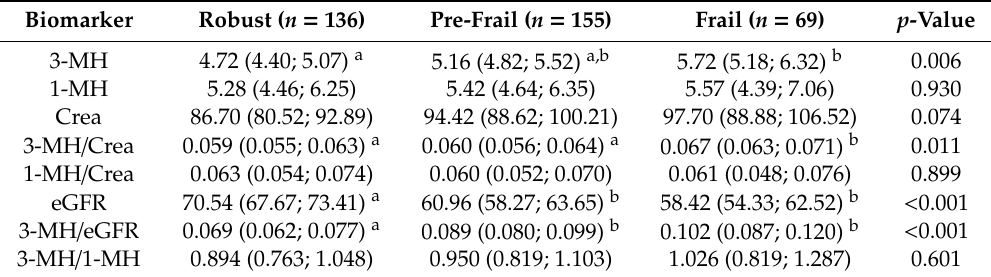
Table 2. Plasma biomarker concentrations [ µ mol / L] and ratios by frailty status among 360 participants of the 3-City Bordeaux and AMI cohorts involved in the FRAILOMIC